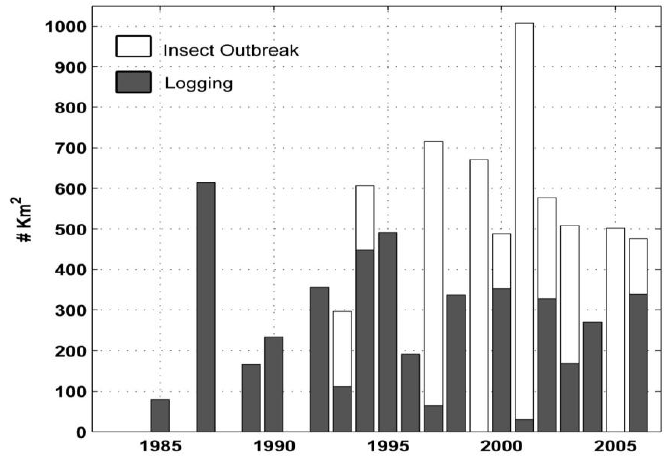
Figure 8. Sum of study region annual area disturbed by insects and